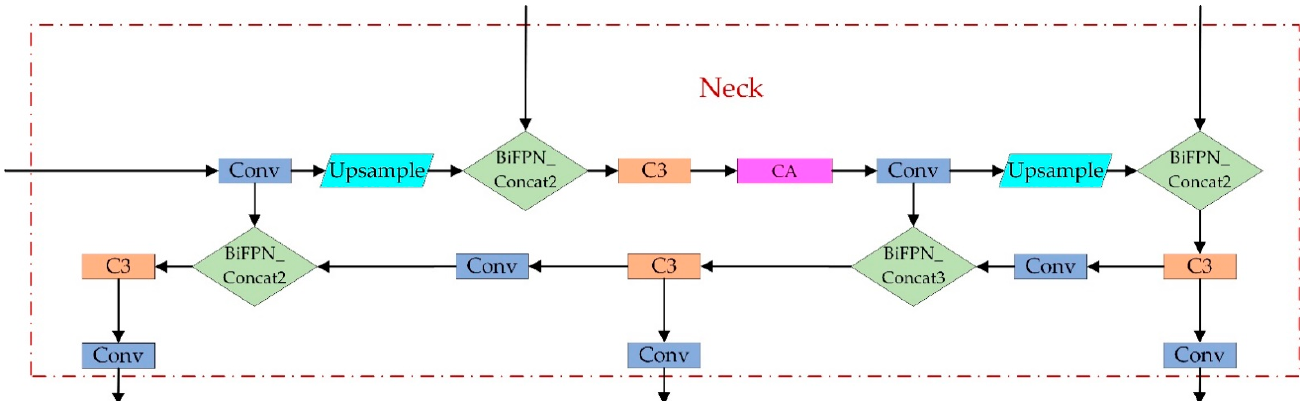
Figure 10. The structure of the improved module.